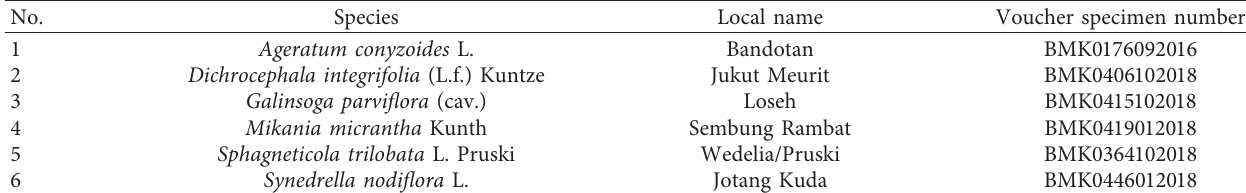
Table 1: Species, local name, and voucher specimen number of all samples used in this